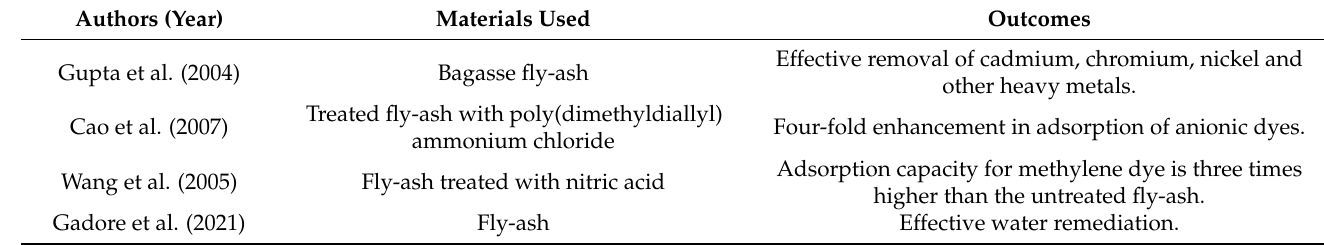
Table 8. Recent studies on modified fly-ash materials for adsorptive application.